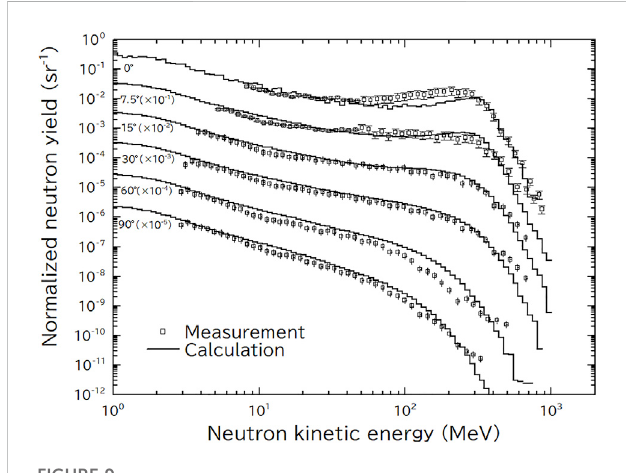
FIGURE 9 Normalized neutron yields for 400 MeV/u C-ion incidence on lead target. The experimental errors include one standard deviation based on an uncertainty